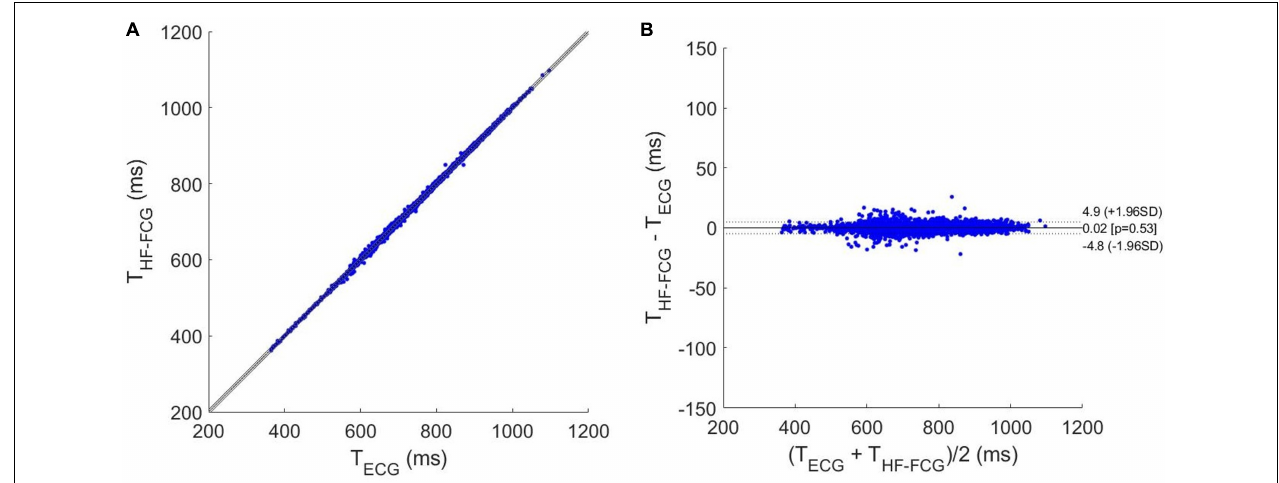
FIGURE 9 | Statistical analyses on inter-beat intervals estimated from ECG and HF-FCG: (A) results of regression and correlation analyses; (B) results of Bland-Altman analysis.